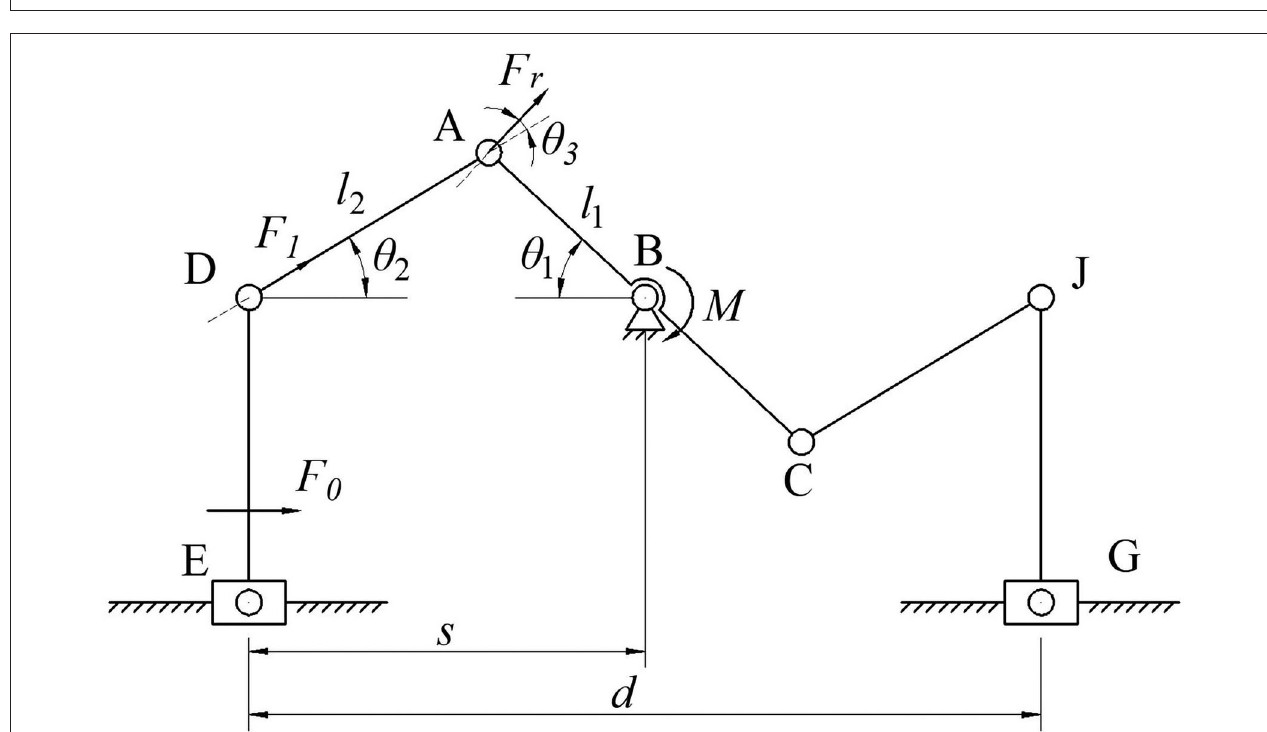
FIGURE 4 | Structure diagram of two-finger translational manipulator.